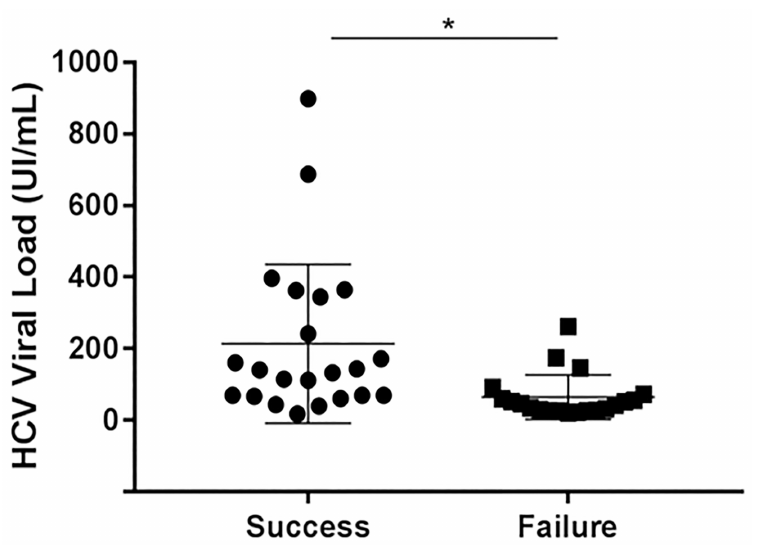
Fig 1. Genotyping results with Roche HCV genotyping kit on samples with low HCV viral load. (p = 0.006) Successes: filled circles; failures: filled squares; (p = 0.006).